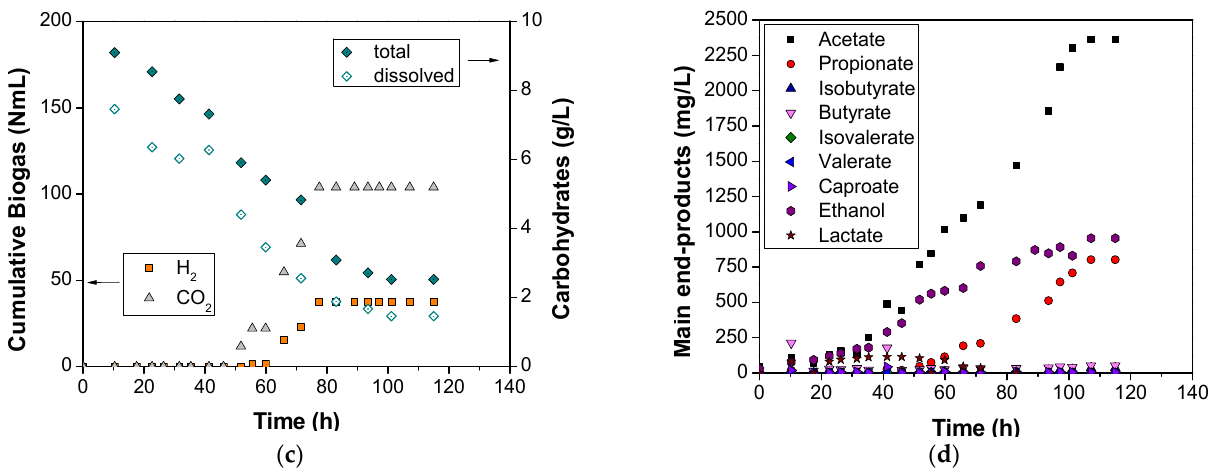
Figure 3. ( a ) Biogas accumulation during the test of pH 6.0; ( b ) metabolites evolution during the test of pH 6.0; ( c ) biogas accumulation during the test of pH 7.5; and ( d ) metabolites evolution during the test of pH 7.5.